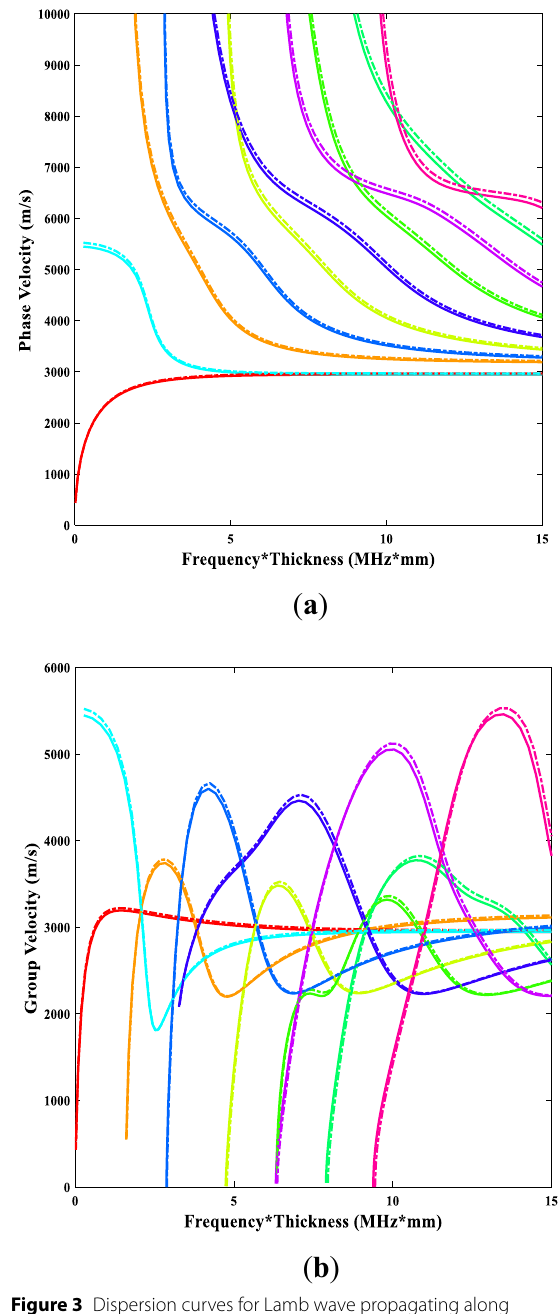
Figure 3 Dispersion curves for Lamb wave propagating along uniform initial stress: ( a ) phase velocity and ( b ) group velocity (solid line: tensile 100 MPa; dash line: compressive 100